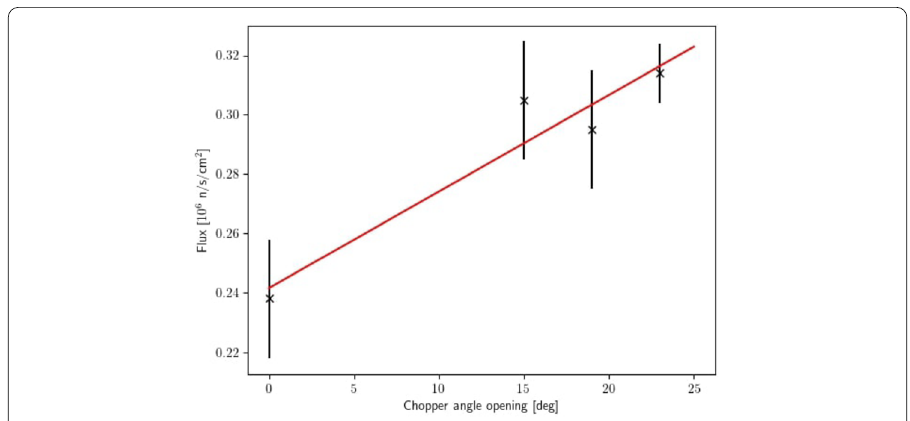
Figure 12 Corrected flux measured with the I-BM vs. flux measured with the 3 He Eurisys Mesures for the 3Å wavelength selection. The figure shows three different settings of SCs (three black points at the top left corner) and a background measurement (point at bottom left)